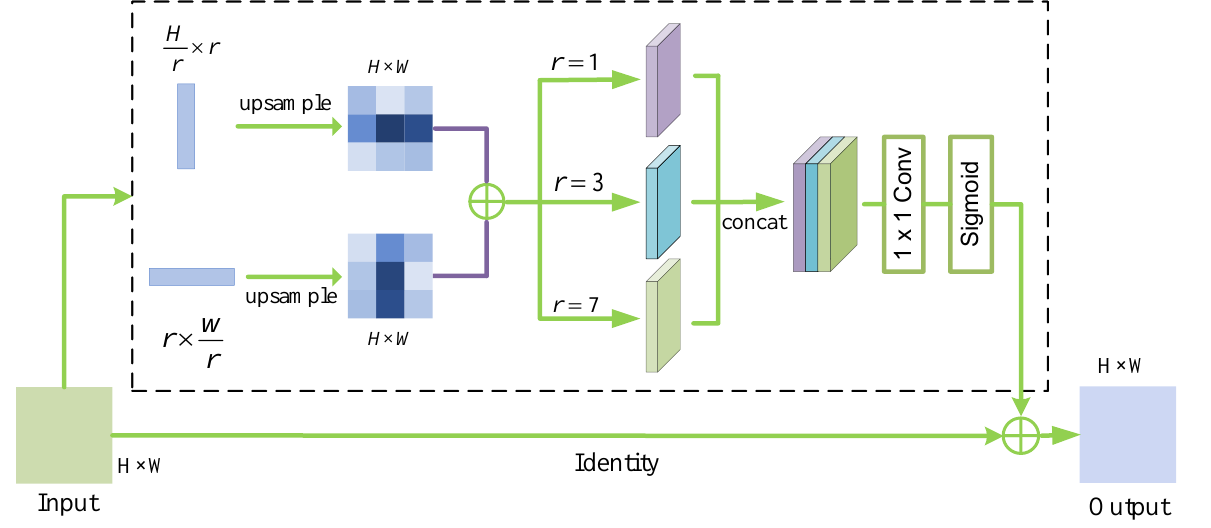
Figure 4. Multi-Scale Strip Pooling (MSP)